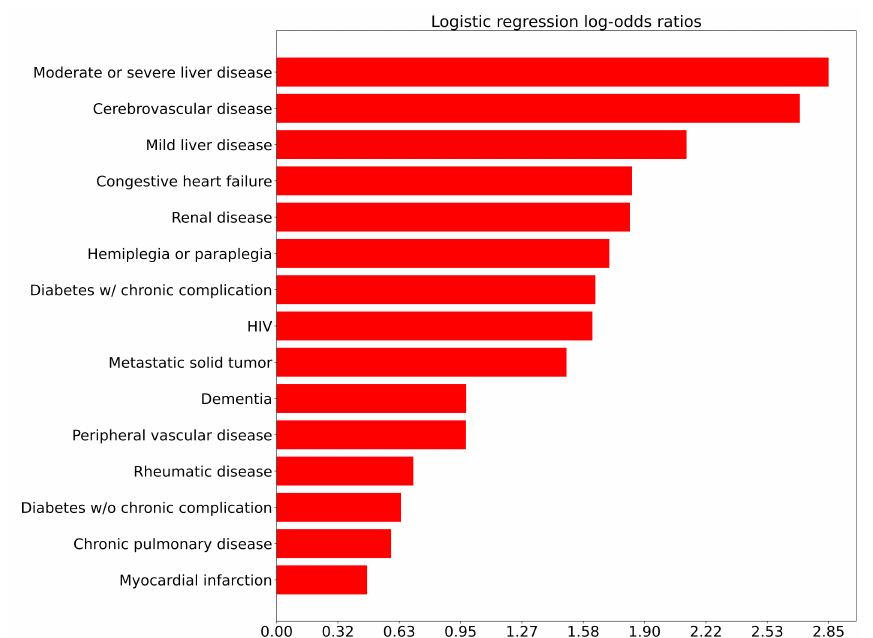
Figure A1. Logistic regression log odds ratios of comorbidities for Comparison 1 (ED admission) adjusted for age.